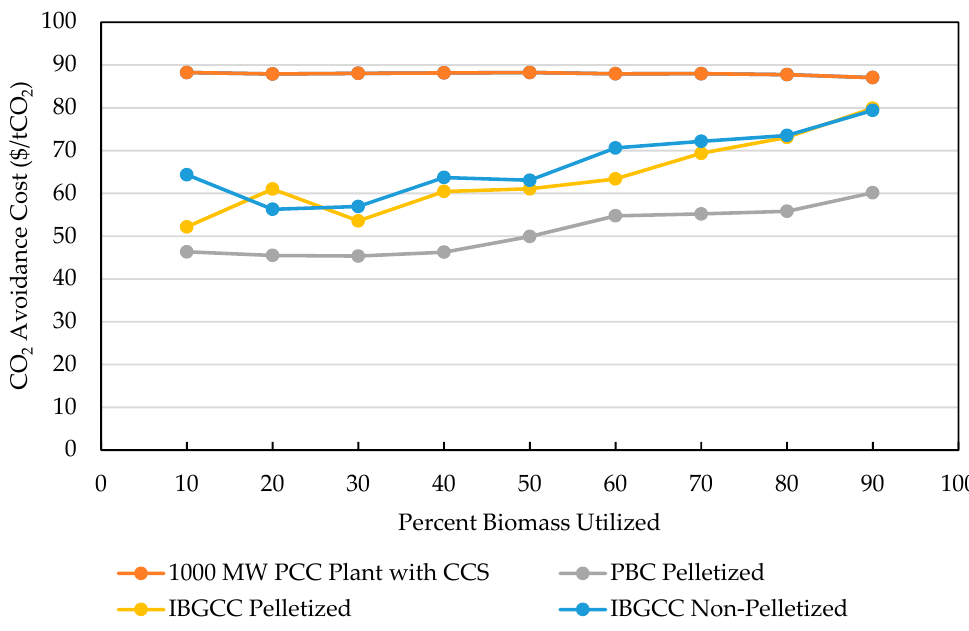
Figure 13. CO 2 avoidance cost comparison for BECCS power plants and a 1000-MW PCC power Figure 13. CO ₂ avoidance cost comparison for BECCS power plants and a 1000-MW PCC power plant with CCS. plant with CCS.